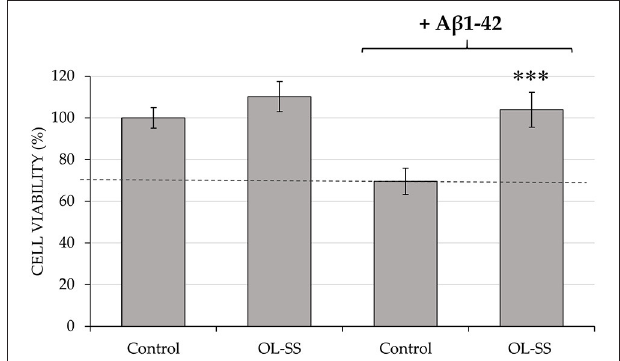
FIGURE 2 | Neuroprotective effect of pre-incubation of olives leaves-sea sand adsorbate (OL-SS) against the neurotoxic agent A β 1–42 in differentiated SH-SY5Y cells. Non A β 1–42-treated cells were used as Control, together with only OL-SS-treated cells at 40 µ g/mL. The results are mean ± SD. *Denotes statistical differences between OL-SS + A β 1–42 and A β 1–42 (*** p <